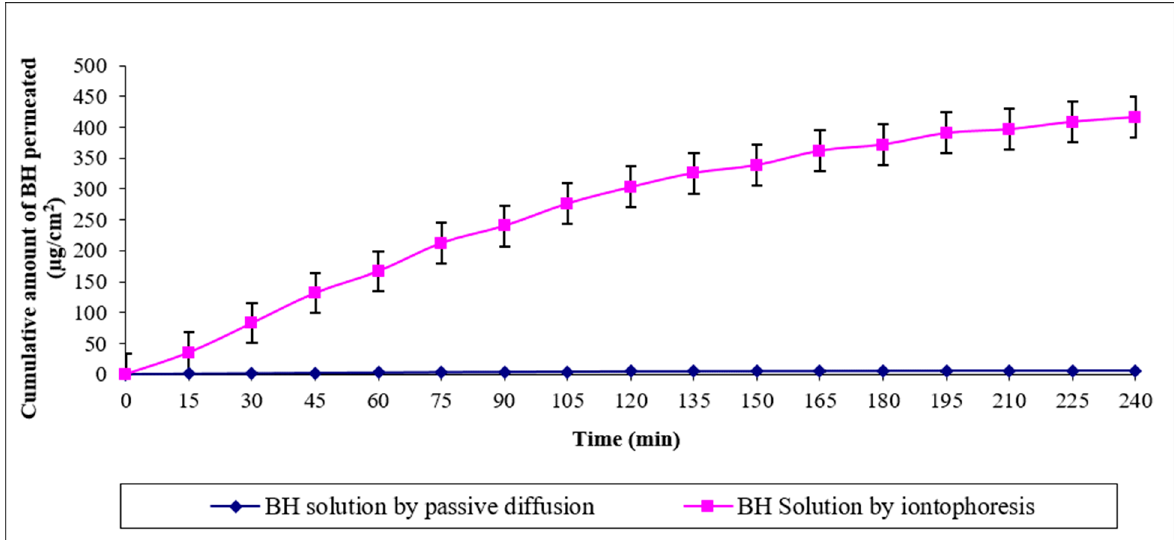
Figure 2. Ex vivo permeation profiles of BH solution by passive diffusion and iontophoresis through rat skin. Table 4. Ex vivo permeation parameters of BH through rat skin.